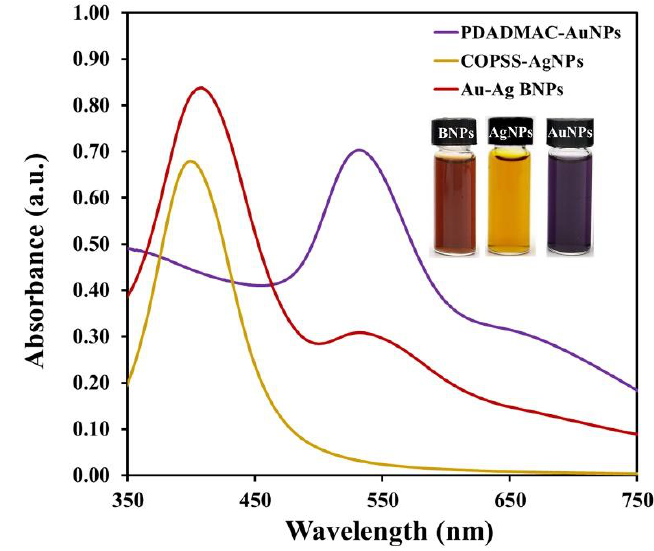
Figure 2. Absorption spectra of PDADMAC–AuNPS, COPSS–AgNPS and the as–prepared Au–Ag BNPs.